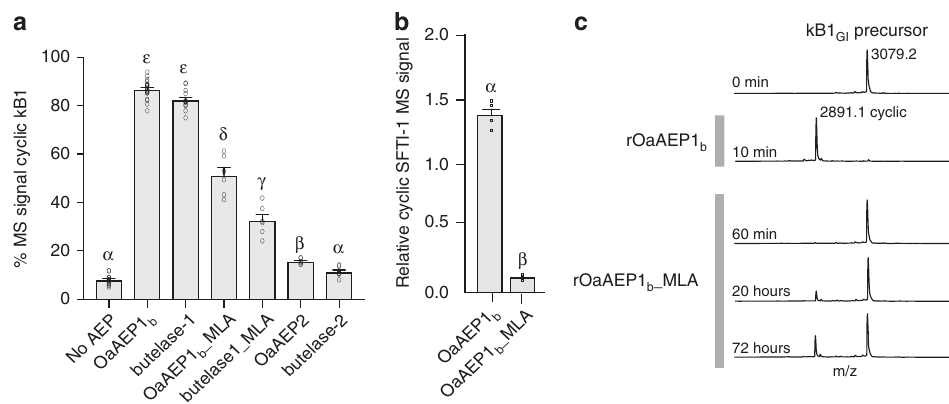
Fig. 4 The MLA in fl uences the yield of cyclic peptide in planta. a MALDI-MS analysis of N. benthamiana -produced peptides upon co-expression of AEP variants with Oak1 . For all treatments, means and s.e.m. are of the percentage MS signal obtained for cyclic kB1 over the total MS signal of all kB1-related peptides produced. Treatments carrying unique Greek lettering are signi fi cantly different ( P < 0.05) as determined by Tukey ’ s ANOVA. Replicates are as follows: n = 14 (No AEP), n = 16 (OaAEP1 b ), n = 13 (butelase1), n = 9 (OaAEP1 b _MLA), n = 6 (butelase1_MLA), n = 6 (OaAEP2), and n = 8 (butelase2). Error bars are s.e.m. b Relative abundance of cyclic SFTI-1 in leaf extracts after co-expression of Oak1_SFTI-1 (Supplementary Fig. 6) with OaAEP1 b ( n = 3) or OaAEP1 b _MLA ( n = 3). Error bars are s.e.m. Treatments carrying unique Greek lettering are signi fi cantly different ( P < 0.05) as determined by Tukey ’ s ANOVA. c In vitro comparison of the enzyme activity preference (protease vs ligase) of recombinant OaAEP1 b and OaAEP1 b _MLA. Representative MALDI- MS pro fi les ( n = 3) of the kB1 precursor (kB1 GI ) incubated with recombinant OaAEP1 b and OaAEP1 b _MLA (each at 23.5 µ g mL − 1 total protein) for up to 72 h. For rOaAEP1b, all precursor peptides were converted to cyclic kB1 (2891.1 m/z) within 10 min, while substantial precursor peptide remained in the case of OaAEP1 b _MLA even after 72 h of incubation. No linear kB1 peptide was detected from either enzyme. Observed monoisotopic masses (Da; [M + H] +